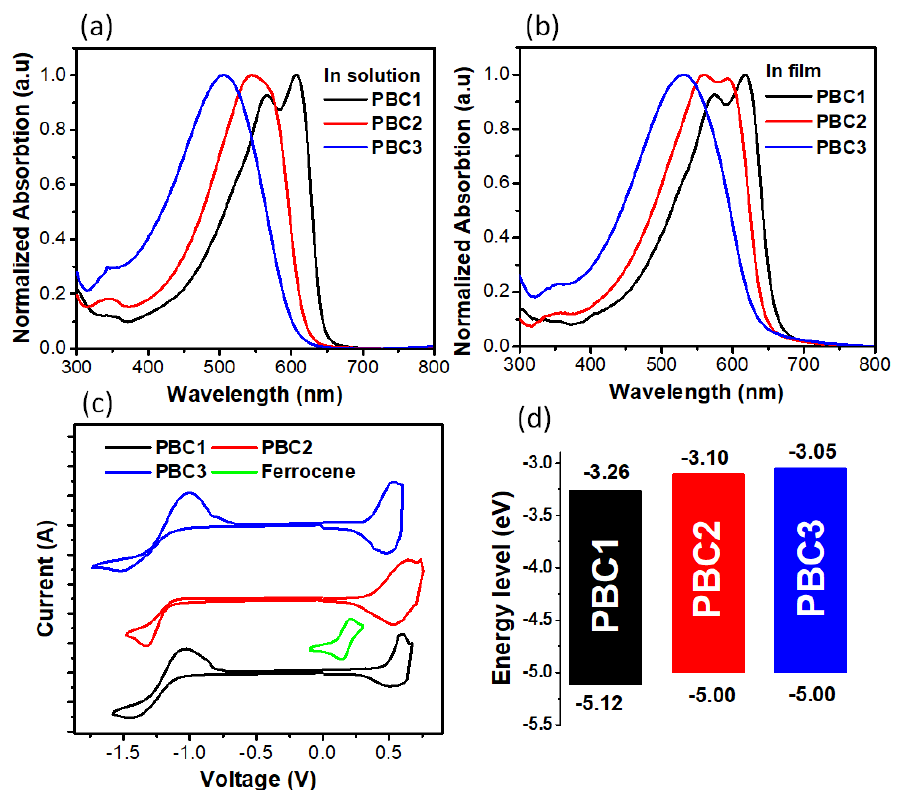
Figure 1. UV-Vis spectroscopy of the synthesized PBC polymers ( a ) in solution and ( b ) in film. ( c ) Cyclic voltamogram of the PBC polymers, and ( d ) the estimated HOMO and LUMO energy levels. Table 1. Optical and electrochemical properties of PBC1, PBC2, and PBC3.